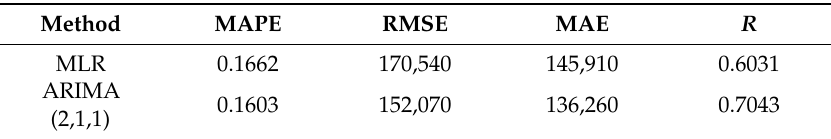
Figure 8. Root mean squared error (RMSE) values in 2000 iterations. Table 3. Performance statistics of the Autoregressive Integrated Moving Average (ARIMA) and Multiple Linear Regression (MLR).